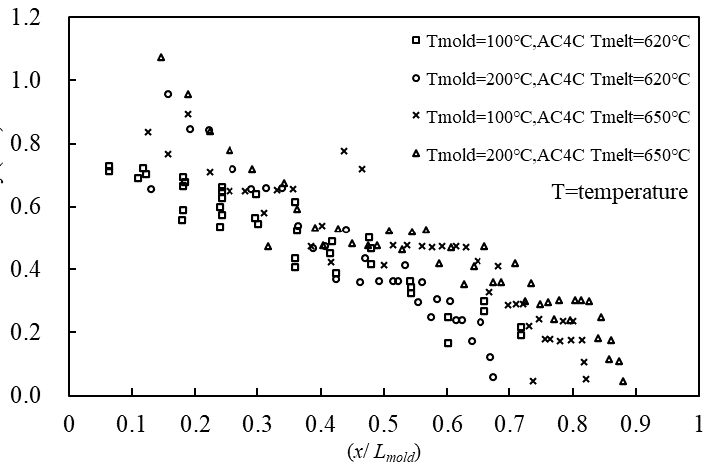
Figure 6. Relationship between the flow velocity and melt tip flow length, as shown by experimental results